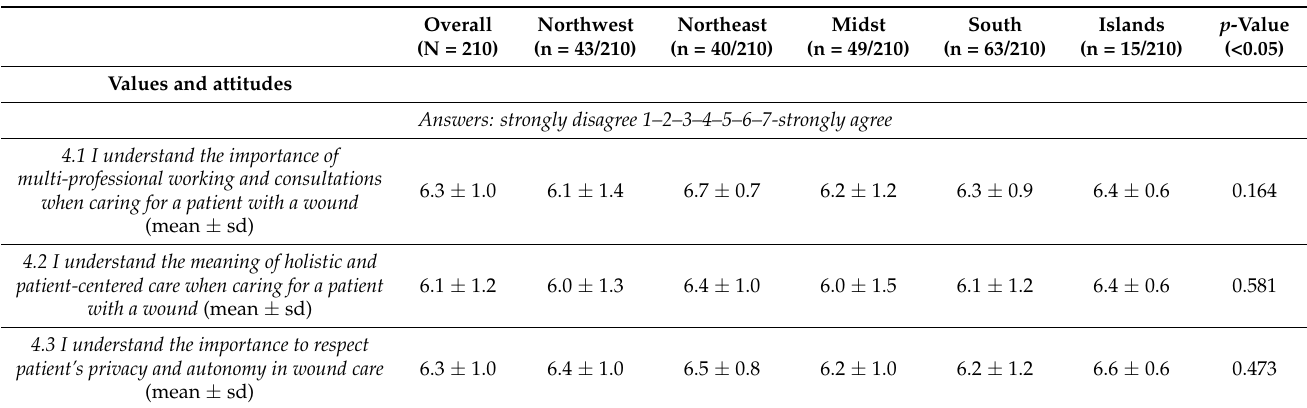
Table 7. Values and attitudes. Each query expects a score value as an answer, based on a seven-point scale (Likert scale) ranging from 1 (strongly disagree) to 7 (strongly agree). Results are shown as mean ± standard deviation (mean ±